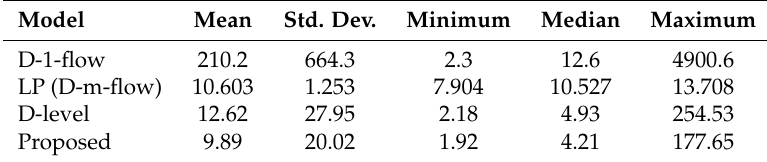
Table 3. Descriptive statistics of the computational times in seconds for the 40-node instances.